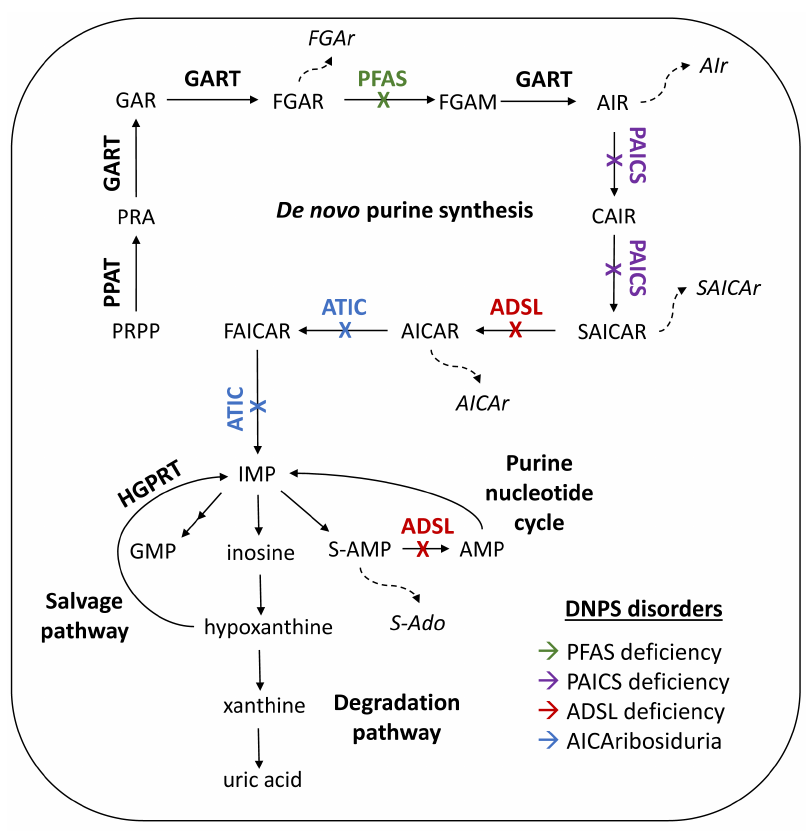
Figure 1. Purine metabolism. De novo purine synthesis (DNPS). Phosphoribosylpyrophosphate (PRPP) is processed by amidophosphoribosyl transferase (PPAT) to phosphoribosylamine (PRA). The 2nd, 3rd, and 5th steps are catalyzed by the trifunctional enzyme glycineamide ribonucleotide synthetase/aminoimidazole ribonucleotide synthetase/glycineamide ribonucleotide transformylase (GART). PRA results in glycineamide ribotide (GAR), from which formylglycineamide ribotide (FGAR) is created. The enzyme phosphoribosylformylglycineamidine synthase (PFAS) catalyzes transformation into formylglycineamidine ribotide (FGAM), which then forms aminoimidazole ribotide (AIR). AIR is processed by the bifunctional enzyme phosphoribosylaminoimidazolecarboxy- lase/phosphoribosylaminoimidazolesuccinocarboxamide synthase (PAICS) into carboxyaminoimi- dazole ribotide (CAIR) and succinylaminoimidazolecarboxyamide ribotide (SAICAR), respectively. The bifunctional enzyme adenylosuccinate lyase (ADSL) catalyzes the reaction of SAICAR to aminoimidazolecarboxamide ribotide (AICAR) in DNPS and succinyl-AMP (SAMP) to adenosine monophosphate (AMP) in the purine nucleotide cycle. The bifunctional enzyme aminoimida- zole carboxamide ribonucleotide transformylase/inosine monophosphate cyclohydrolase (ATIC) catalyzes the last two steps that result in formamidoimidazolecarboxamide ribotide (FAICAR) and inosine monophosphate (IMP). IMP is precursor for synthesis of guanosine monophosphate (GMP) and AMP. Defects in DNPS enzymes lead to accumulation of ribosides, the dephosphorylated DNPS metabolites: FGAr, AIr, SAICAr, AICAr, succinyladenosine (SAdo). Enzymes connected with DNPS disorders are distinguished by colors: green for PFAS deficiency, purple for PAICS deficiency, red for ADSL deficiency, blue for AICAribosiduria. The main salvage enzyme of purines— hypoxanthineguaninephosphoribosyl transferase (HGPRT)—catalyzes conversion of hypoxanthine into IMP and guanine into GMP (not shown). Degradation of purines goes through IMP to inosine, hypoxanthine, xanthine to the final product uric